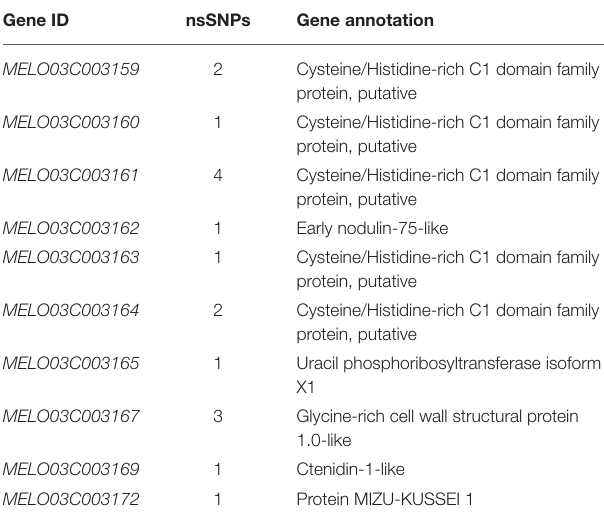
TABLE 6 | Predicted 10 genes with non-synonymous single-nucleotide polymorphisms (SNPs) between markers S8P19 and